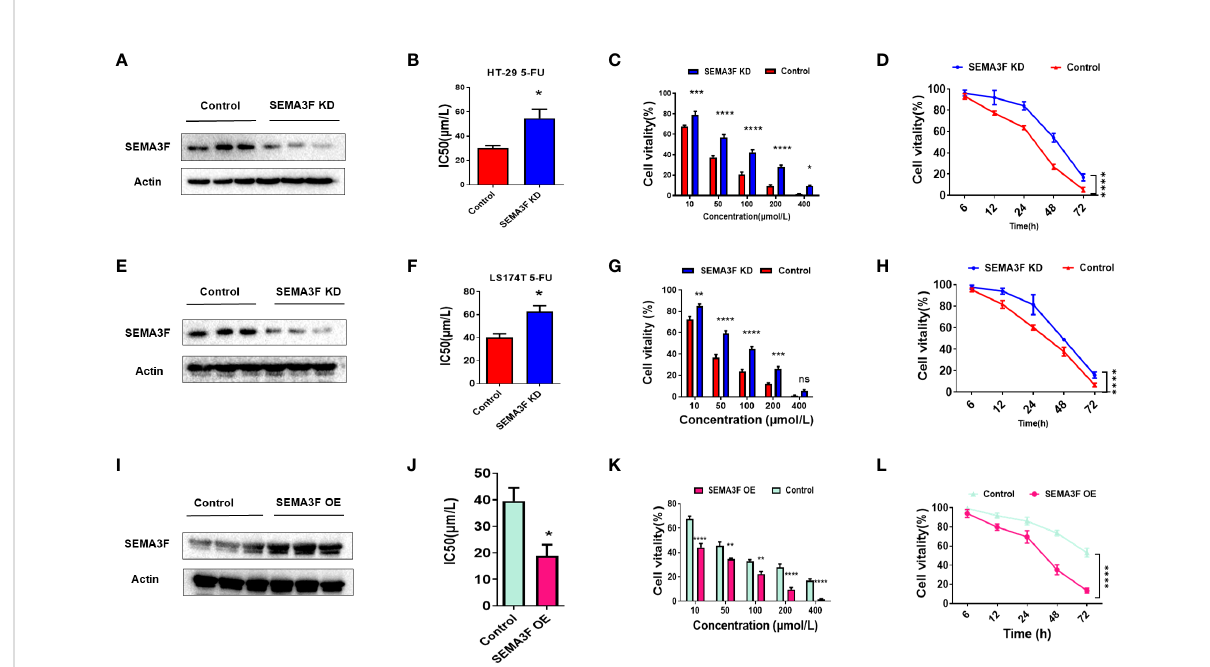
FIGURE 2 SEMA3F activity determines the chemotherapeutic response of CRC cells to 5-Fu in vitro. (A) SEMA3F was knocked down in HT-29 cells. (B) The IC50 value of 5-Fu in HT-29 cells under MSC conditions was higher in the SEMA3F KD group than in the control group (*P<0.05). (C)